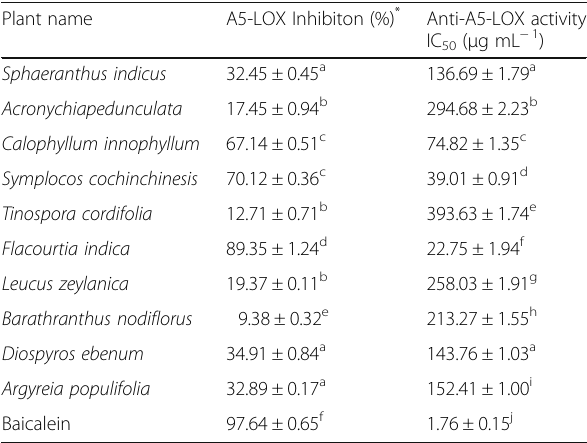
Table 2 Anti-A5-LOX activity of ethanol extracts of medicinal plants